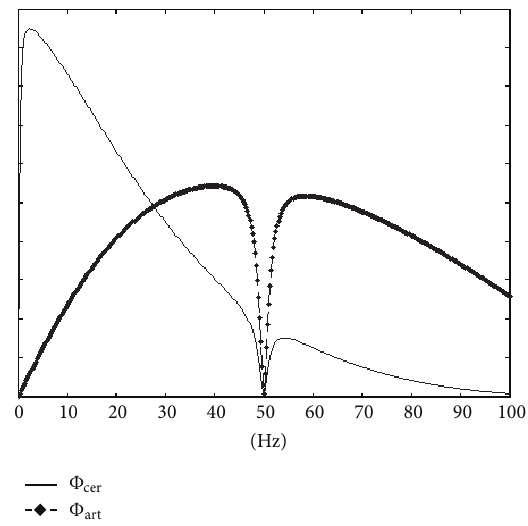
Figure 2: The two frequency windows used for DAFOP optimiza- tion in order to have CCA equivalence. The windows take into accountthepreprocessingoftherecordingproposedin[2](i.e.,high pass at 0.3 Hz, low pass at 35 Hz, and notch filter at 50